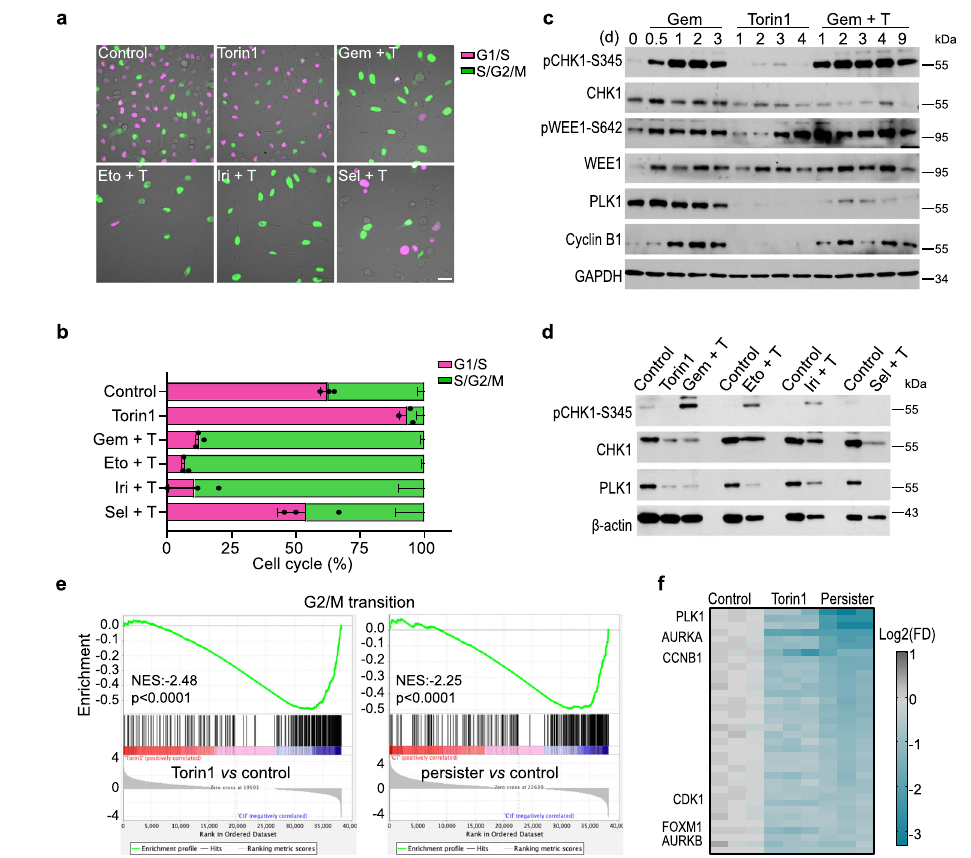
Fig. 6 | mTOR inhibition potentiates G2/M cell cycle arrest and promotes persister survival. a , b Cell cycle tracking with FUCCI reporter in control, Torin1- treated, and persister cells. Cells were treated with 100nM Torin1, or Torin1 plus chemotherapeutic agents (100nM gemcitabine, 2 μ M selinexor, 6 μ M etoposide, and 6 μ M irinotecan) for nine days. Experiments were performed with three bio- logical replicates. Data plotted as mean±SEM. Scale bar, 50 μ m. c Western blot analysisofkeyproteinsinvolvedinG2/McheckpointactivationandG2/Mcellcycle progression. MIA PaCa-2 cells were treated with 100nM gemcitabine, 100nM Torin1, or the combination for the indicated days. The experiment was repeated once with similar results. d Western blot analysis of phospho-CHK1-S345 and PLK1